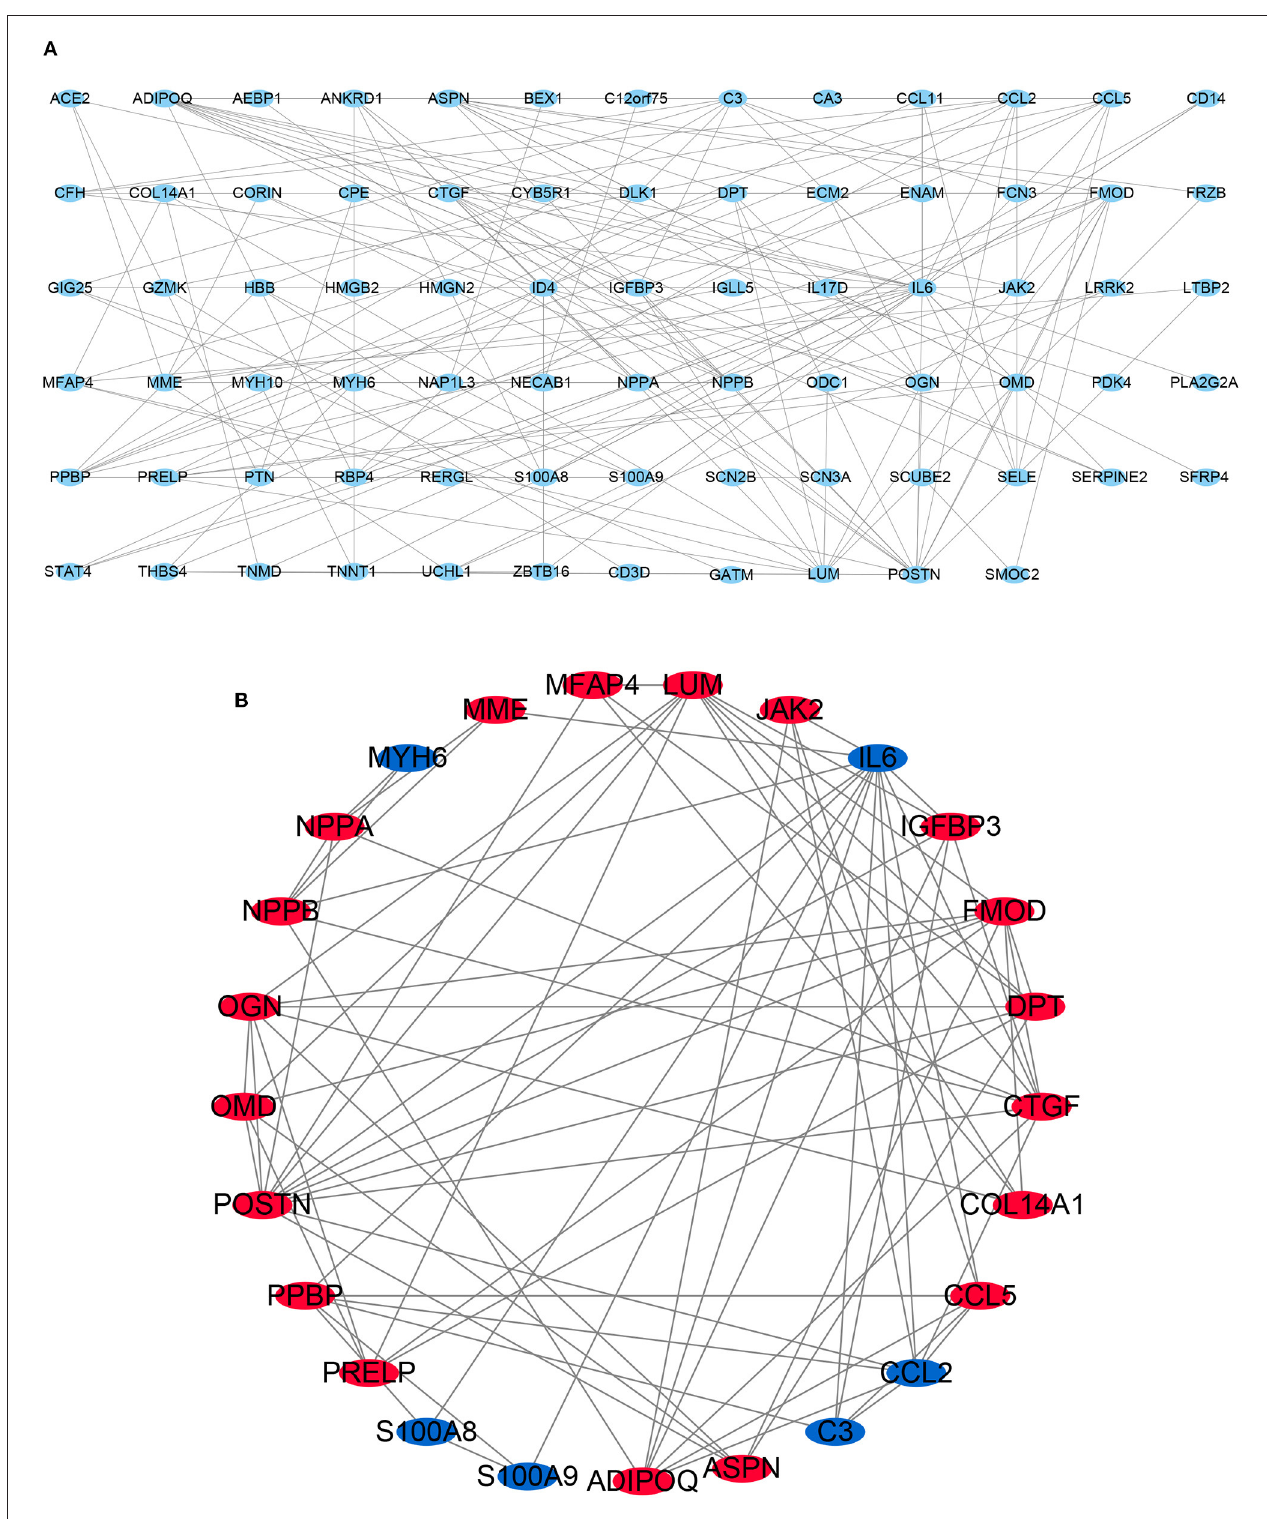
FIGURE 4 | Protein-protein interaction (PPI) network. (A) PPI network of 117 differentially expressed genes (DEGs). (B) subnetwork of top 25 genes with the highest degree of connectivity from the PPI network. Node color reflects the degree of connectivity (Red color represents a higher expression, and blue color represents a lower